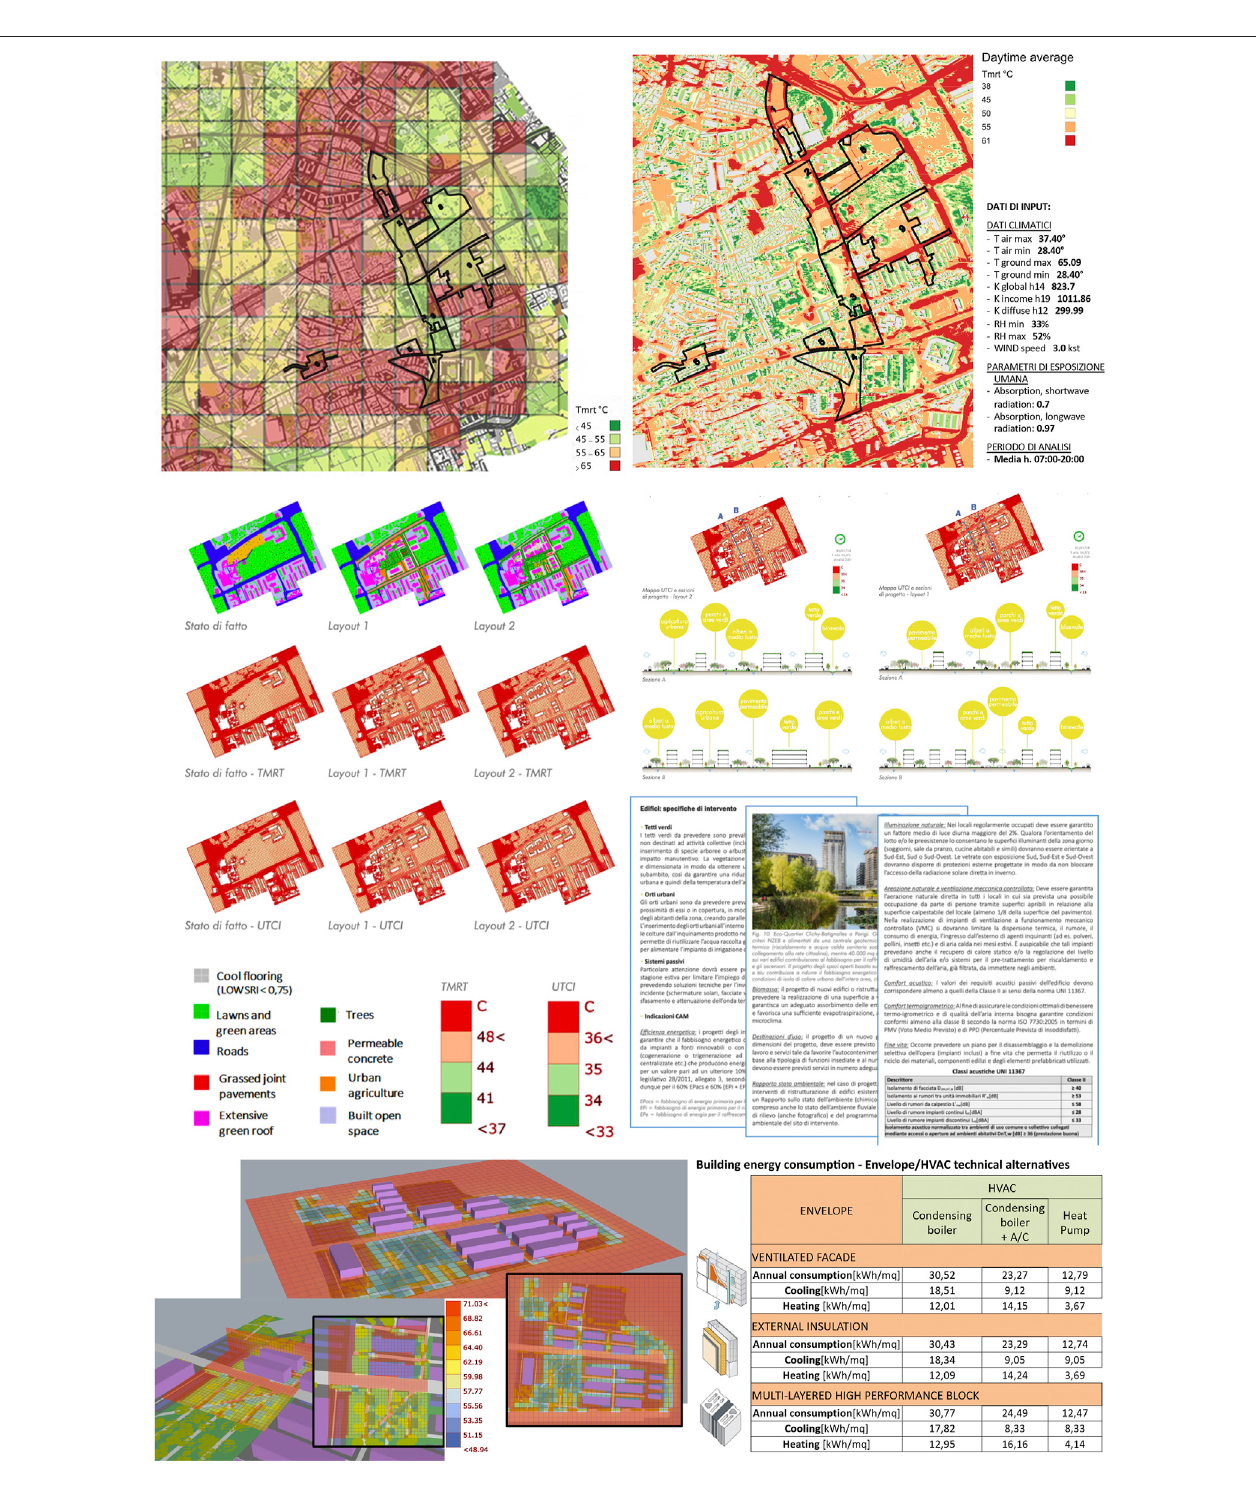
FIGURE 13 | Analysis of a neighborhood development project from a private initiative subject to Strategic Environmental Assessment (SEA).